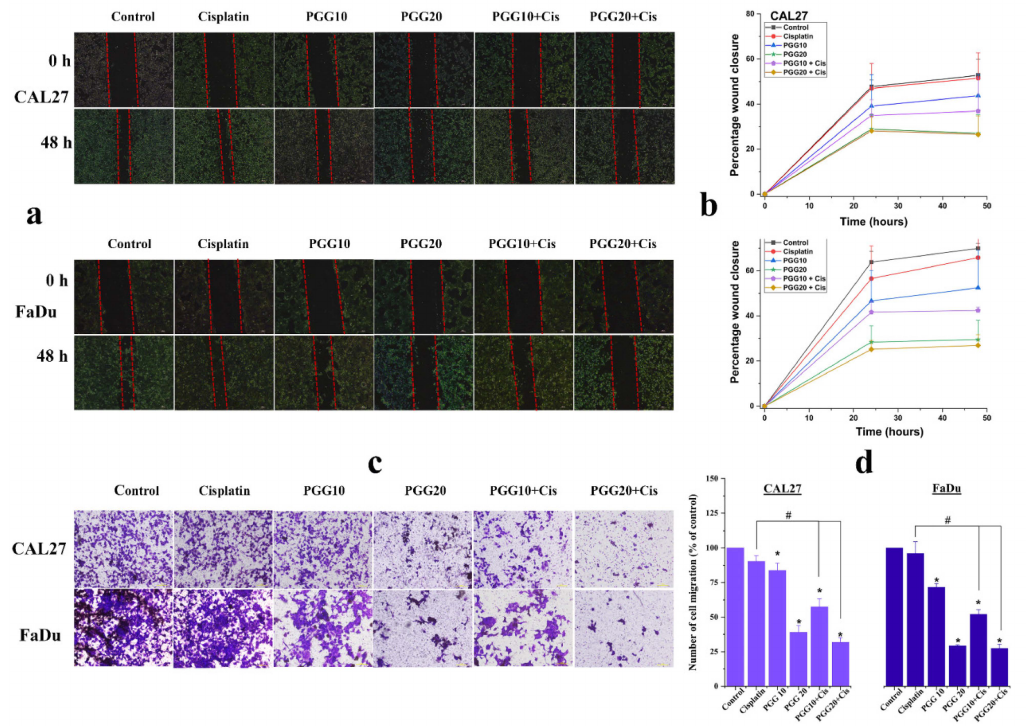
Figure 4. Effects of PGG combined with cisplatin on the migration and invasion of HNSCC cancer cells. Representative microscopic images of wound healing ( a ) and quantification of the percentage of wound closure ( b ) showing the effect of PGG (10, 20 µ g/mL) or cisplatin (2 µ g/mL) alone, or PGG and cisplatin combined treatment. ( c ) Transwell chamber images of cell migration after treatment with PGG (10, 20 µ g/mL) or cisplatin (2 µ g/mL) alone or a combination of PGG and cisplatin. Scale bar = 100 µ m. ( d ) The quantitative number of migrant cells. All data are expressed as the mean ± SD of three independent experiments. * p < 0.05: significantly different from control, and # p < 0.05: significantly different from PGG and cisplatin treatment alone. PGG, pentagalloyl glucose; Cis,